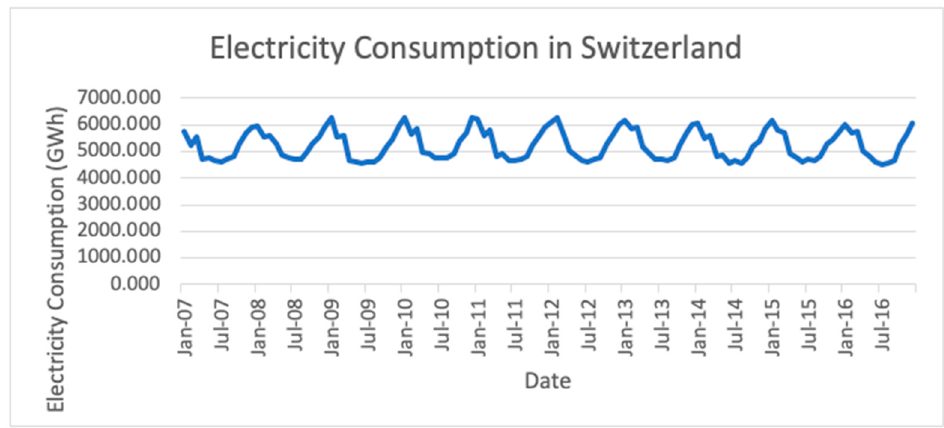
Figure 6. Electricity consumption in Switzerland from 2007 to 2016.